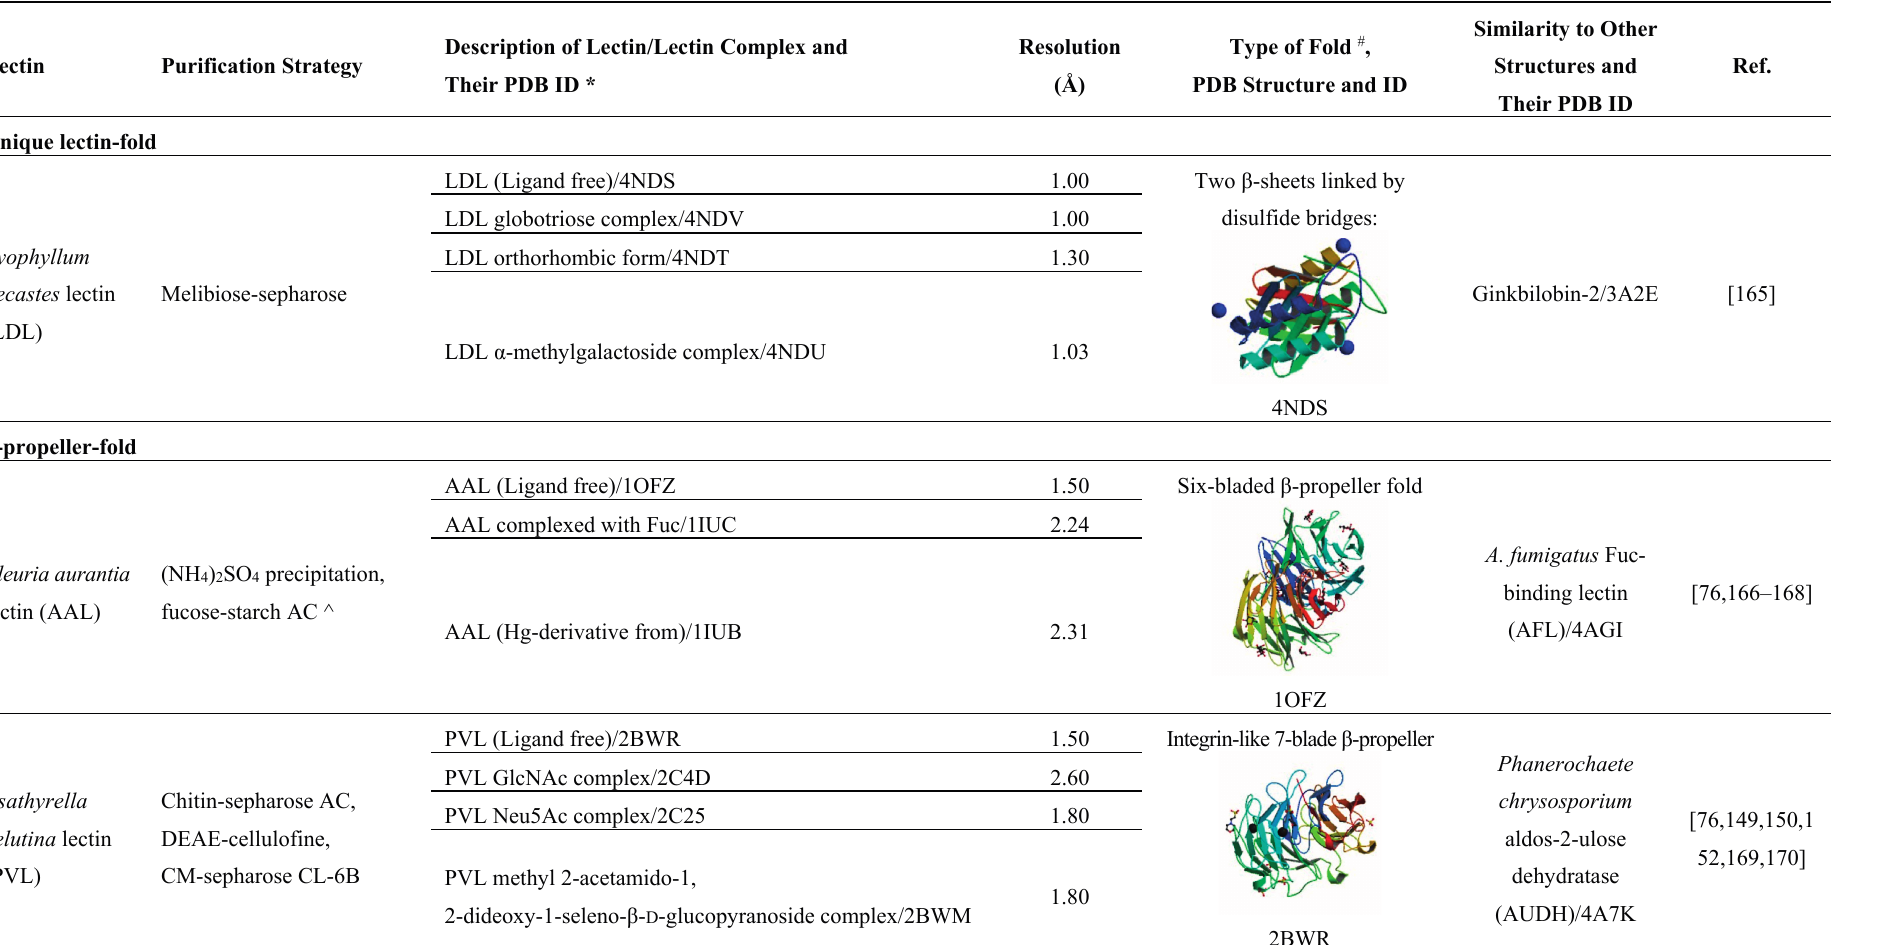
Table 2. Common structural characteristics and strategies used to purify mushroom lectins for which crystal structure data